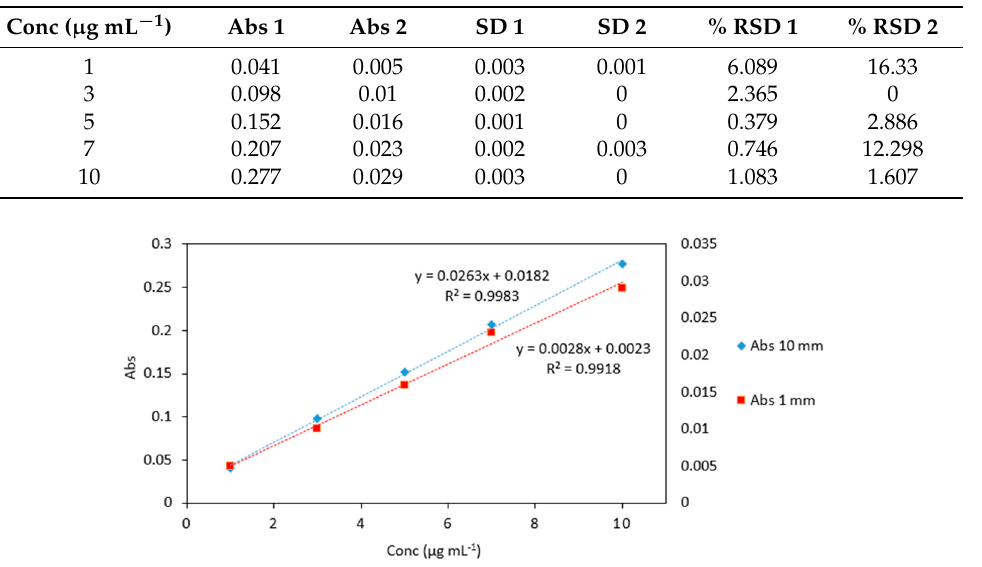
Figure 3. Comparison of arsenic standards (1–10 μ g mL − 1 ) measured in quartz cuvettes with 10 mm and 1mm path lengths. Left vertical axes represents the absorbance of standards analyzed in 10 mm quartz cuvettes (blue markers). Right vertical axes represents the absorbance of standards analyzed in 1mm quartz microcuvettes (red markers). All measurements were carried out in triplicate.